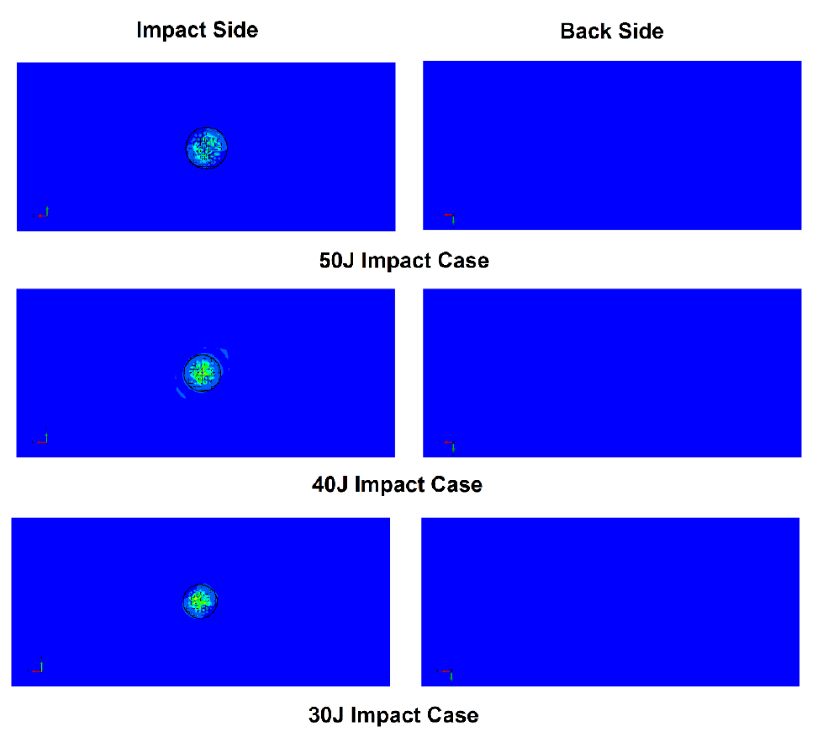
Figure 13. Local dent morphology for three impact energy cases.